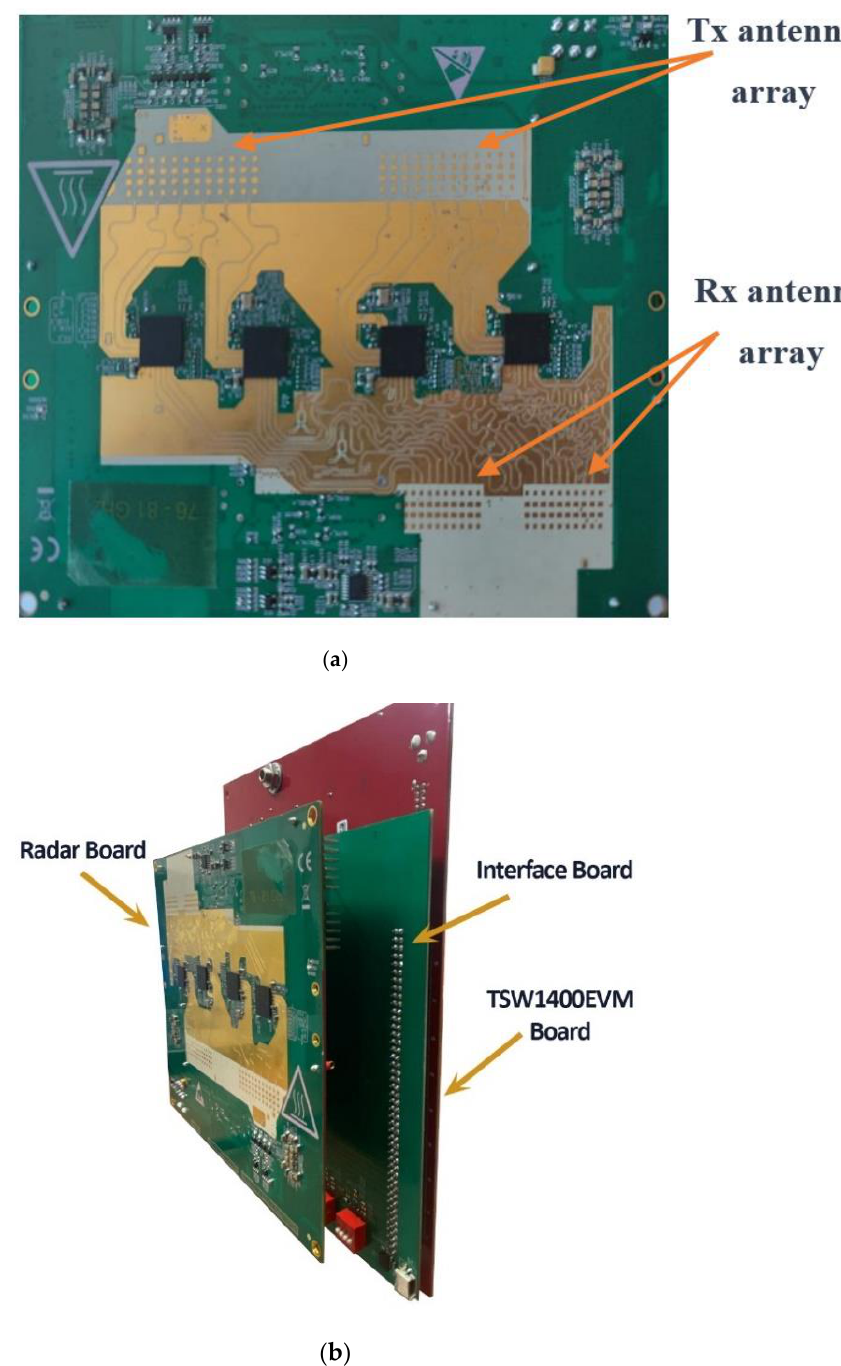
Figure 16. 77 GHz radar system: ( a ) fabricated VAA radar board; ( b ) fabricated VAA radar board connected to the TI’ TSW1400EVM board via an interface board.